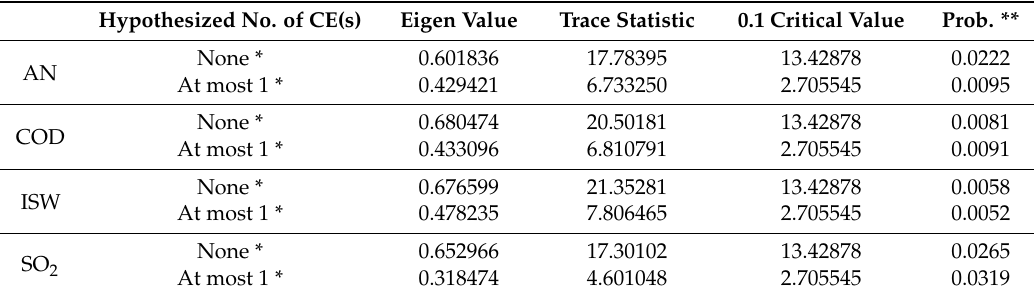
Table 10. Johansen co-integration test for ferrous metal ore mining and processing.